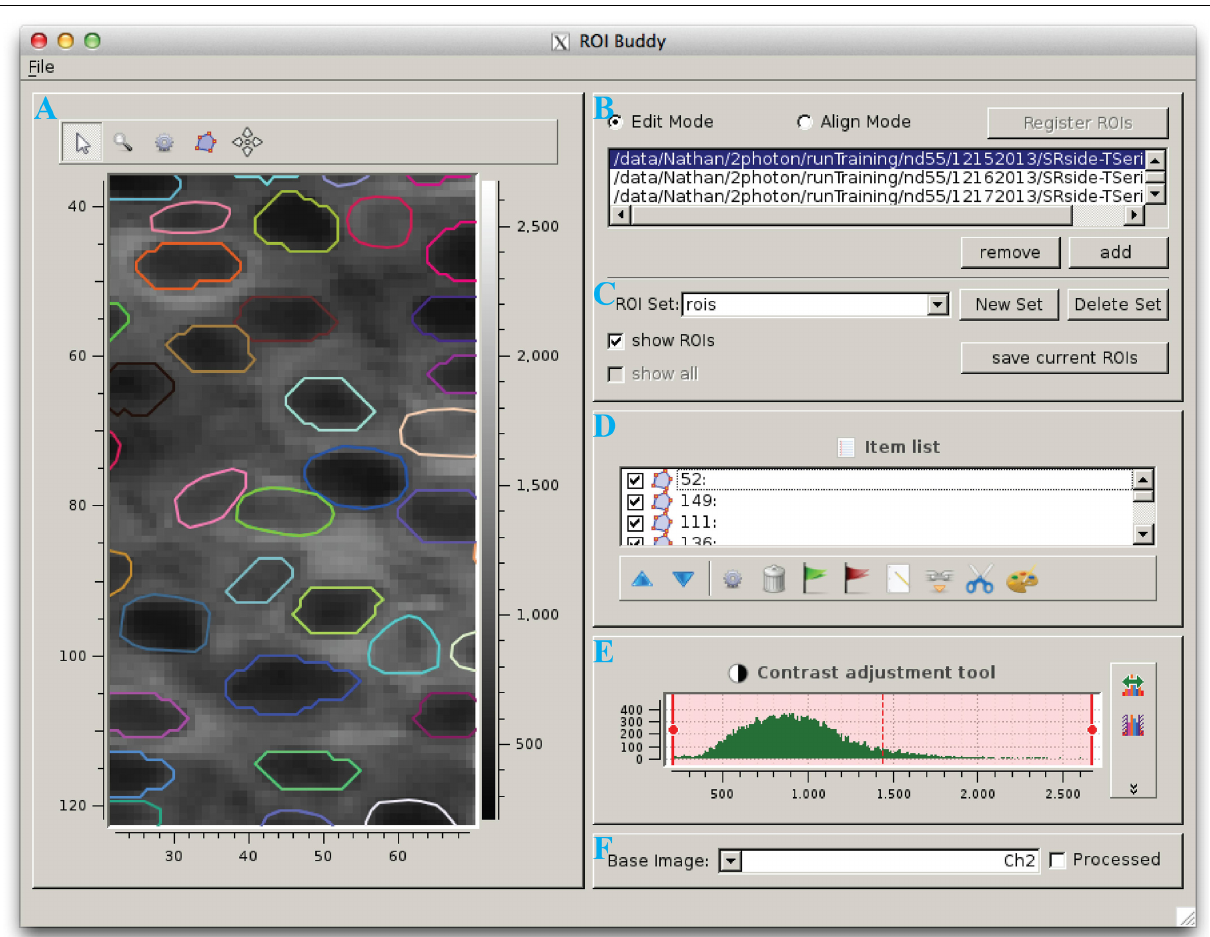
associated with the active imaging dataset. In “Align” mode, ROIs from all loaded datasets can be viewed simultaneously. (D) List of ROIs in the currently selected set, and tools for tagging, merging, unmerging, and re-coloring ROIs. (E) Contrast adjustment for the underlying base image. (F) Panel for selection of the underlying base image.